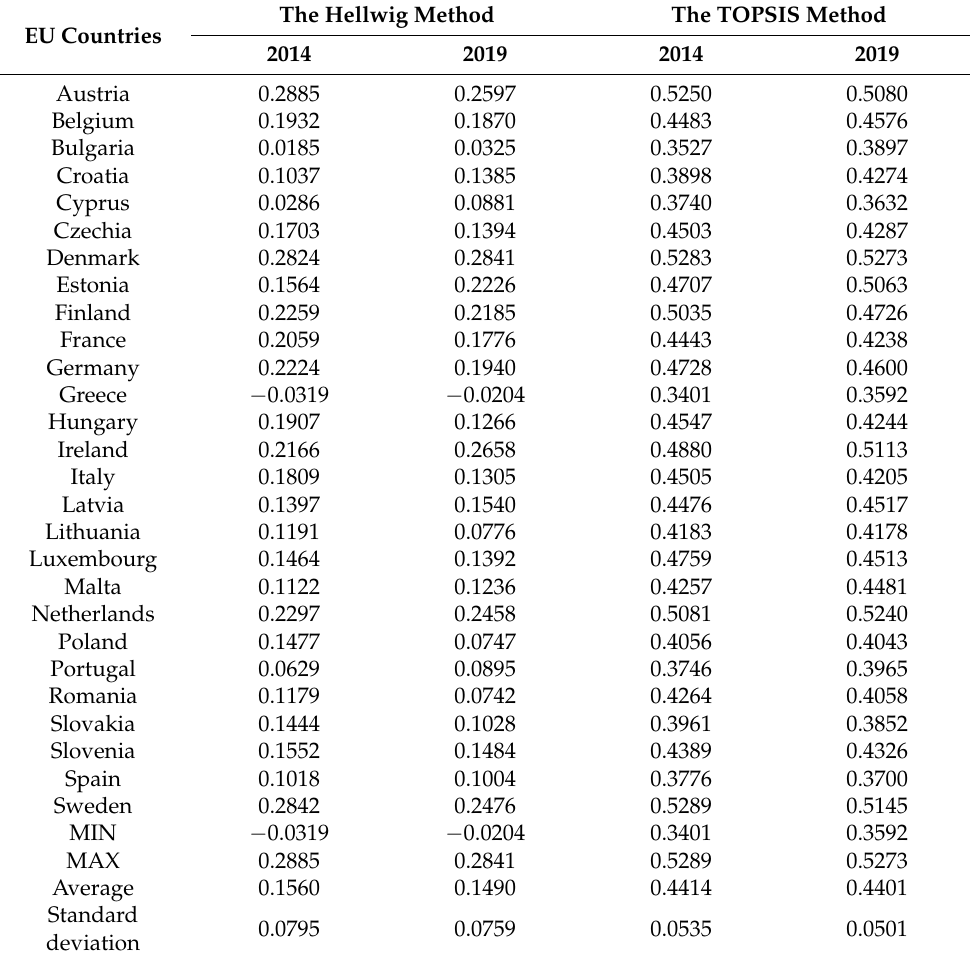
Table 2. The taxonomic